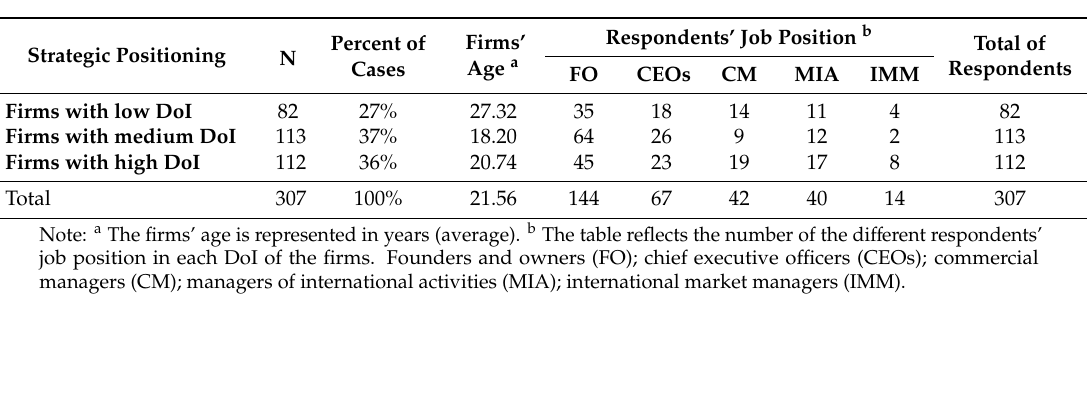
Table 1. Firms’ strategic groups, firms’ age and the respondents’ job